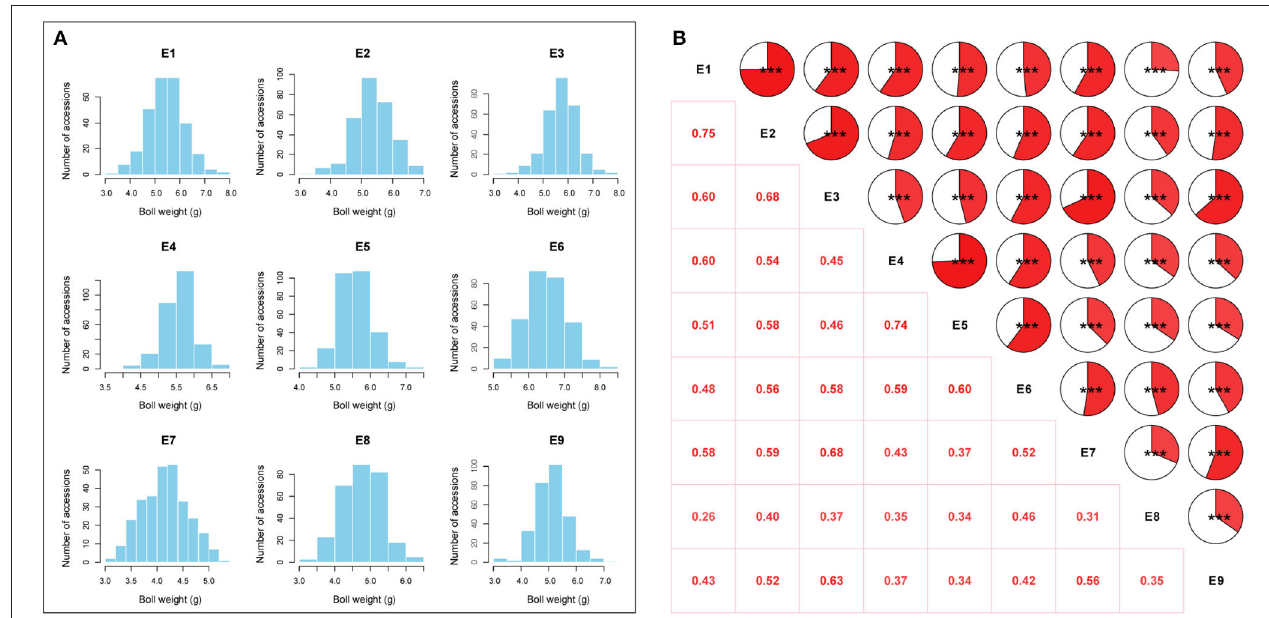
FIGURE 2 | Phenotypic variation analysis of boll weight. (A) Distributions of the mean values for boll weight in nine environments (E1: Anyang-2014, E2: Anyang-2015, E3: Anyang-2016, E4: Shihezi-2014, E5: Shihezi-2015, E6: Shihezi-2016, E7: Huanggang-2016, E8: Huanggang-2021, and E9: Sanya-2020-2021). (B) Correlation analysis of boll weight in nine environments (*** P < 0.001, ** P < 0.01, and * P <